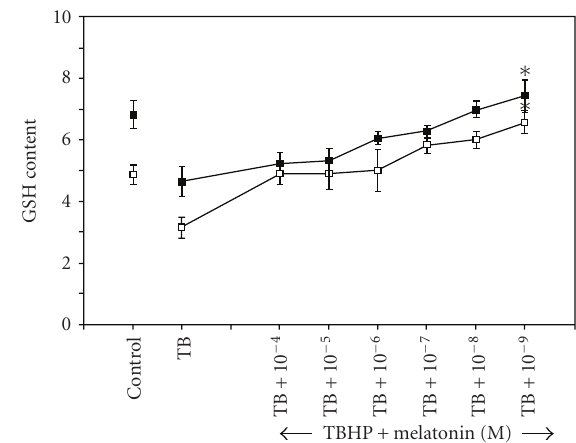
Figure 4: Day and night variation in reduced glutathione (GSH) content in red blood cells after in vitro treatment with melatonin. The points ( (cid:2) ) and ( (cid:3) ) represent the e ff ect of melatonin in diurnal and nocturnal blood samples respectively. Dose-dependent variation was observed in both diurnal and nocturnal samples in response to in vitro treatment. Significant change was observed at 10 − 9 M concentration of melatonin ( ∗ P < . 05). GSH content is expressed as milligram per millilitre packed